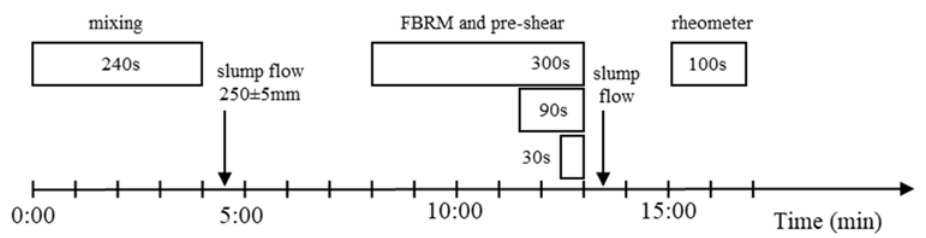
Figure 1. Time sequence of the investigations.